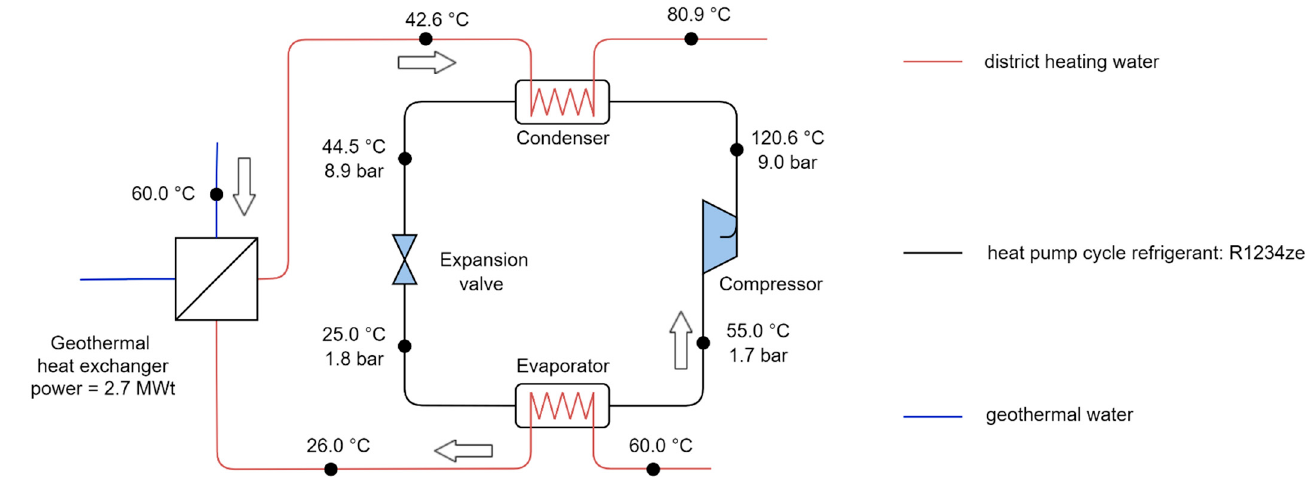
Figure 7. Scheme of the subcooling variant.